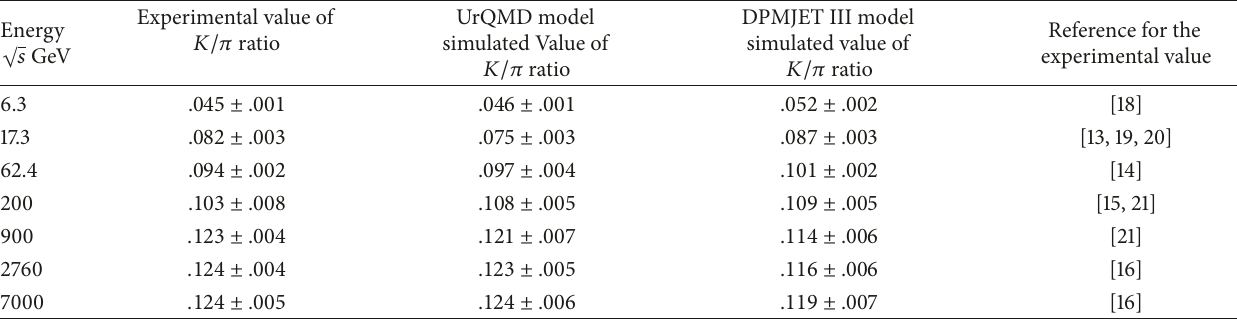
Table 3: It represents the values oftotal kaon to pion multiplicity ratio ((𝐾 + +𝐾 − )/(𝜋 + +𝜋 − ) = 𝐾/𝜋) in pp collisions at √𝑠 = 6.3 GeV to 7 TeV in the framework of UrQMD and DPMJET III model along with the experimentally obtained